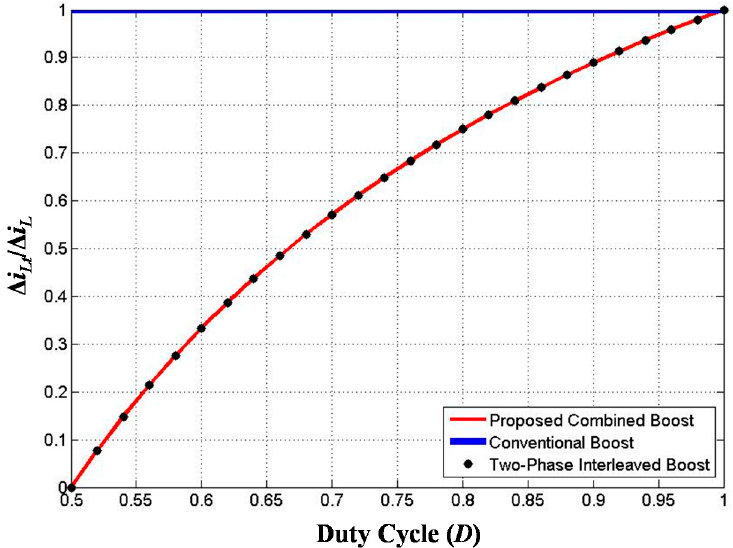
Figure 6. The ratio between the total current ripple and the inductor current ripple versus the duty cycle.